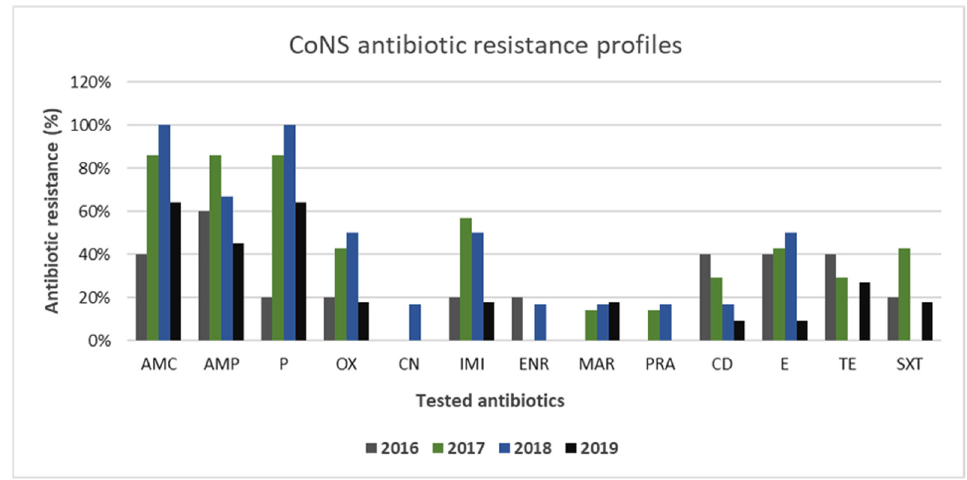
Figure 7. Antimicrobial resistance profiles of canine CoNS strains to commonly used antibiotics.